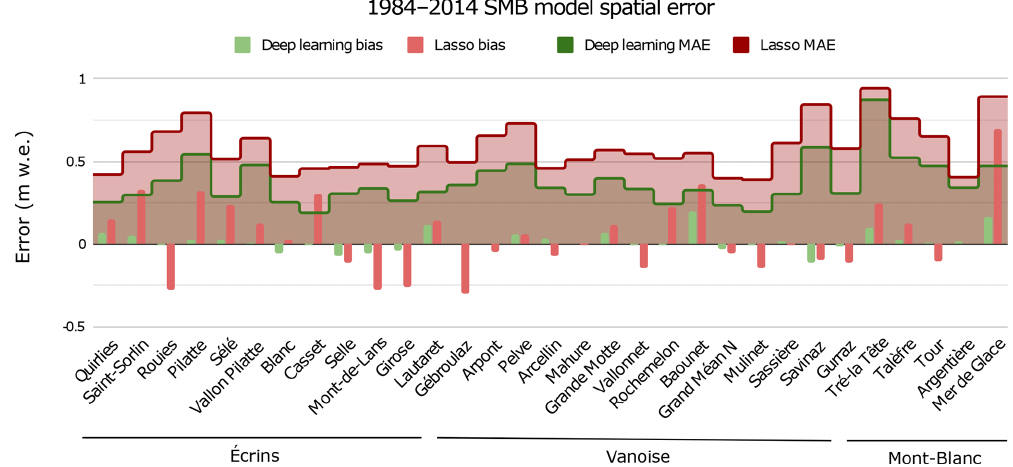
Figure 8. Mean average error (MAE) and bias (vertical bars) for each glacier of the training dataset structured by clusters for the 1984–2014 LOGO glacier-wide SMB simulation. No clear regional error patterns arise.